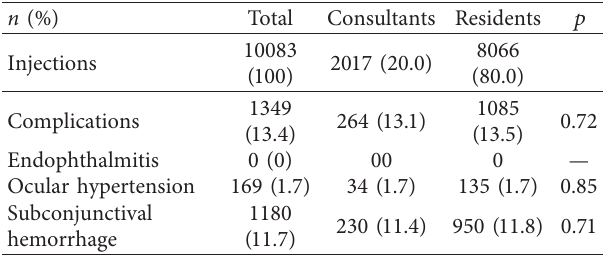
Table 3: Postoperative complications evaluated in consultants and residents